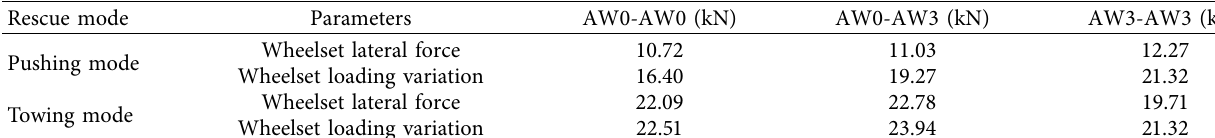
Figure 12: Vehicle dynamic responses when AW0 rescues AW0. (a) Wheelset lateral force. (b) Wheelset loading variation. Table 7: Maximum values of wheelset load.